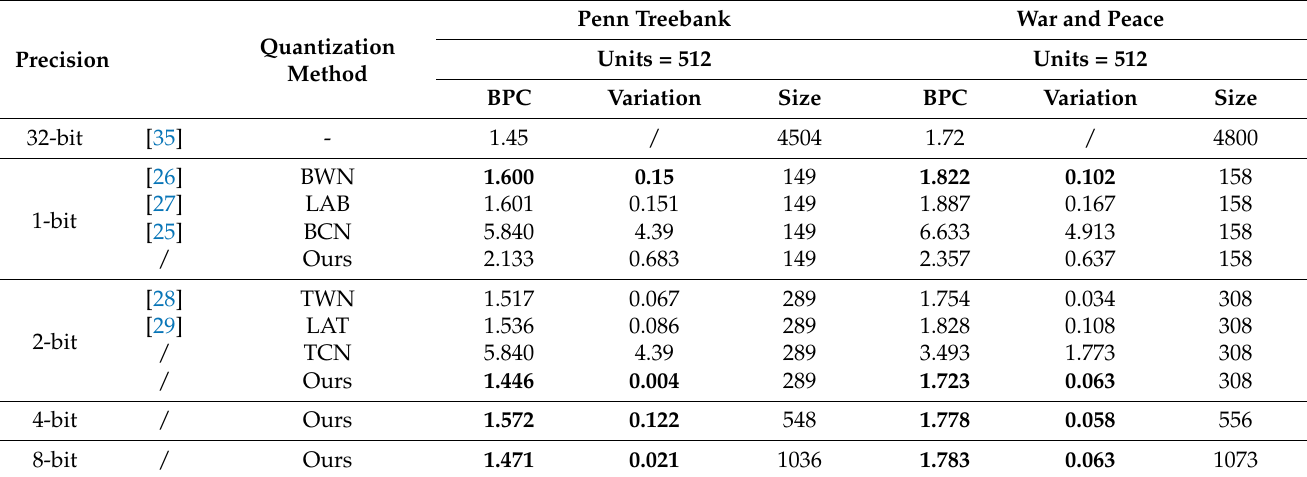
Table 3. Test BPC and size (in KB) of LSTM on character-level language